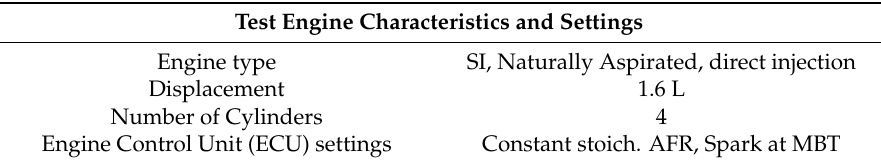
Table 1. Characteristics and settings of the tested